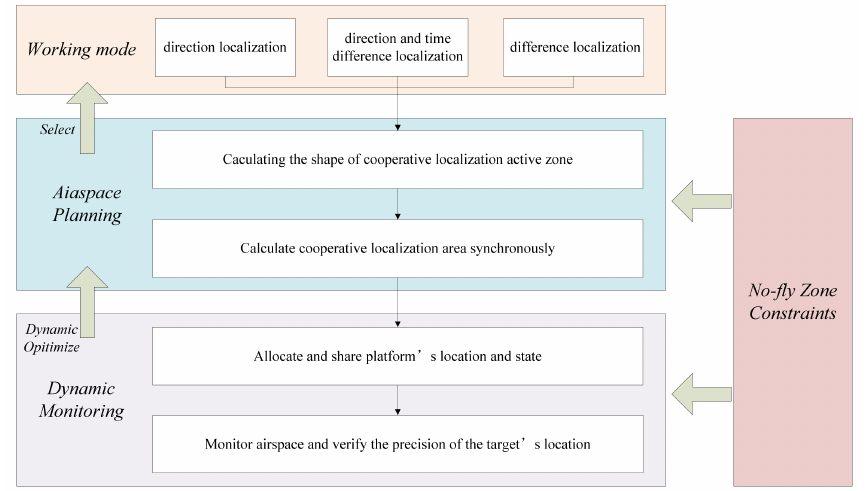
Figure 1. Flowchart of the proposed